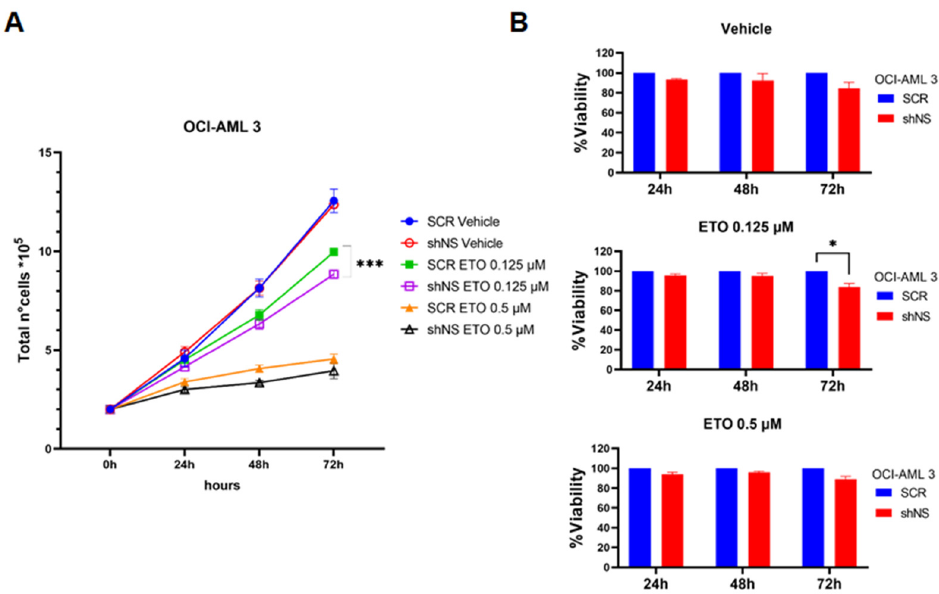
Figure 5. Lower doses of etoposide in combination with NS silencing reduce proliferation rates of OCI-AML 3 cells. ( A ) Proliferation rates of OCI-AML 3 cell lines, silenced (shNS) or not (SCR) for NS, and treated with DMSO 0.1% (vehicle), 0.125 µM or 0.5 µM etoposide (ETO), graphed on the base of the total number of cells counted at each time point for each condition considered, as indicated. Seventy-two hours post-induction with doxycycline was considered the starting point of the curve. *** p < 0.001, Student’s t -test. Representative data graphed as means ± SDs of two independent experiments, each performed in quadruplicate. ( B ) Cell viability assays of OCI-AML 3 SCR and shNS cells treated with DMSO 0.1% (vehicle), 0.125 µM or 0.5 µM etoposide (ETO), expressed as the percentage fold change ratio of viability of NS-silenced OCI-AML 3 cells over SCR controls for each time point indicated and for each treated condition, considering 72 h doxycycline post-induction as the starting point of the curve. * p < 0.05, two-way ANOVA. Representative data graphed as means ± SDs of three independent experiments, each performed in eight technical replicates.